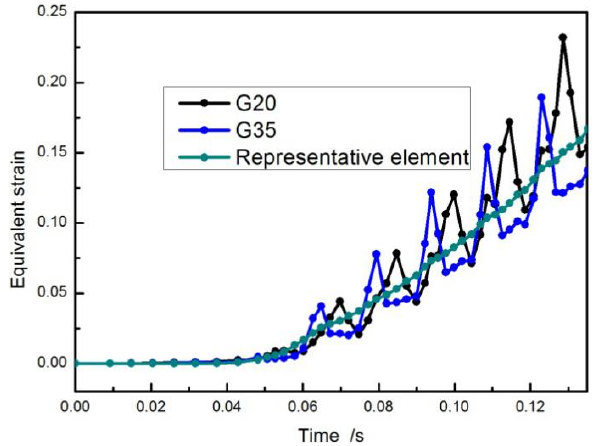
Figure 11. Equivalent strain curve of the polycrystalline representative element.